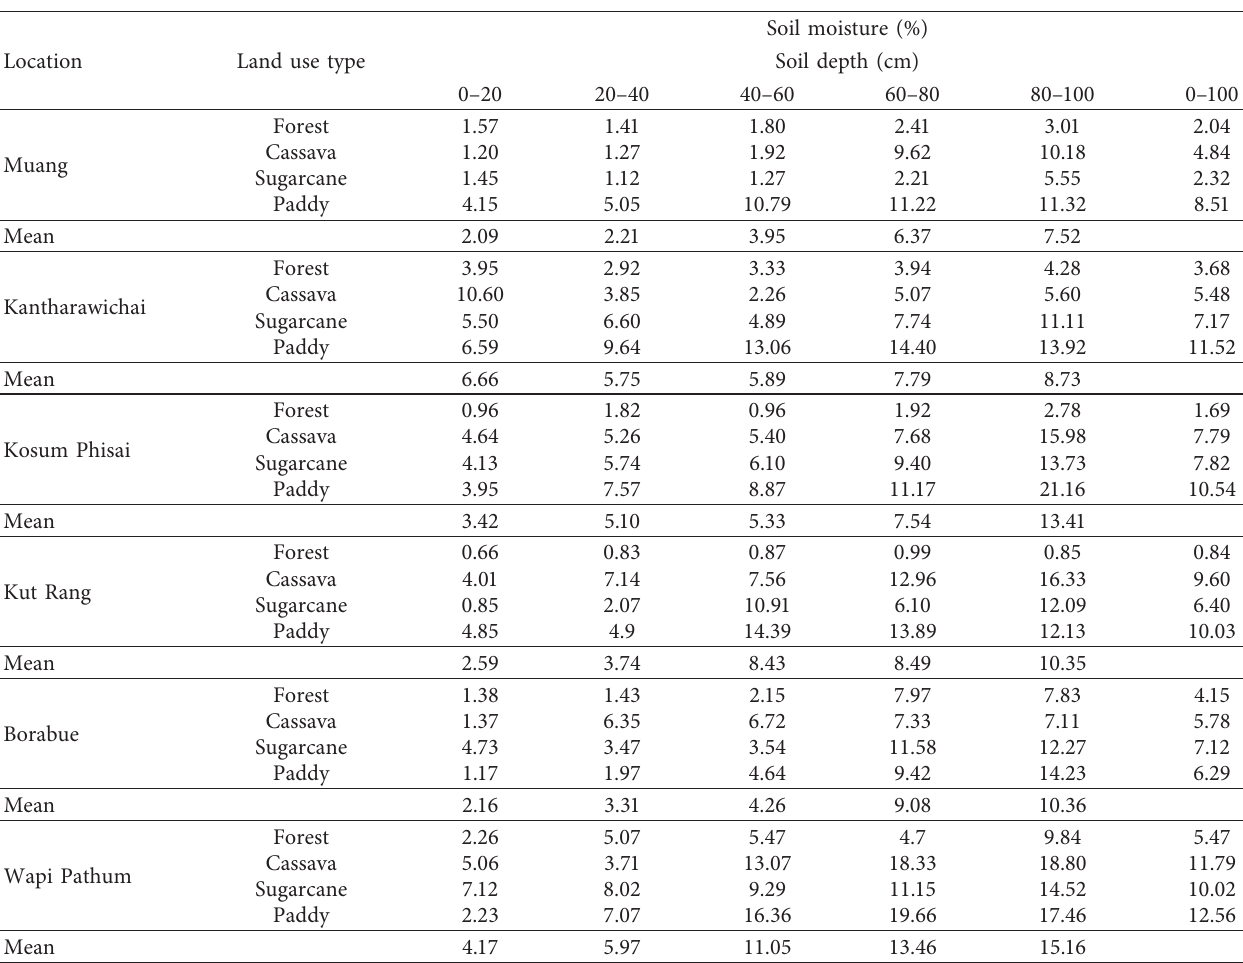
Table 4: Land use altitude and moisture in soil profile under different land